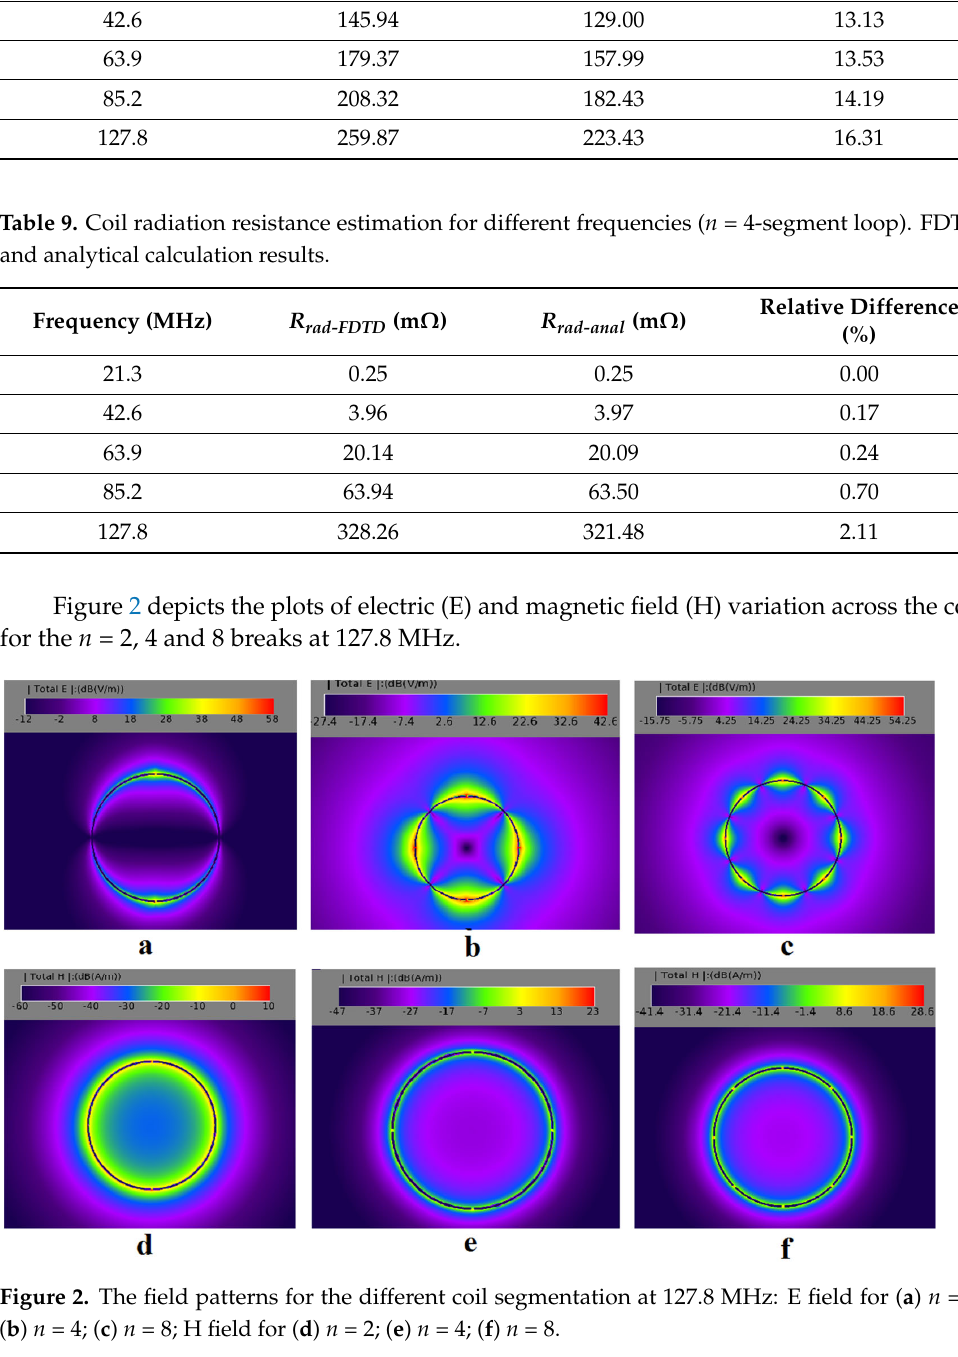
Table 8. Coil conductor resistance estimation for different frequencies ( n = 4 ‐ segment loop). FDTD